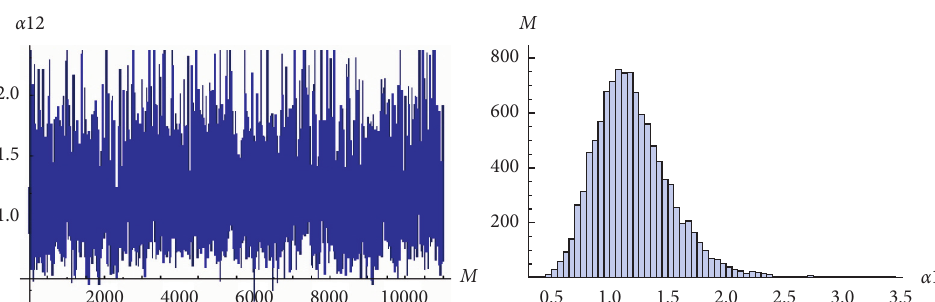
Figure 5: Simulation MCMC generated number/histogram of the parameter β